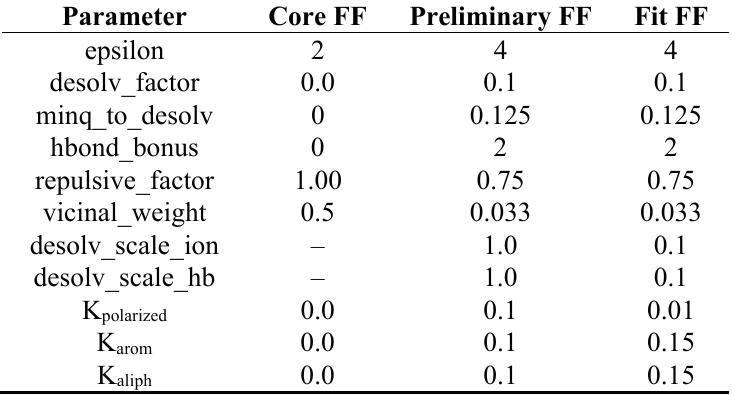
Table 2. Considered FF parameter